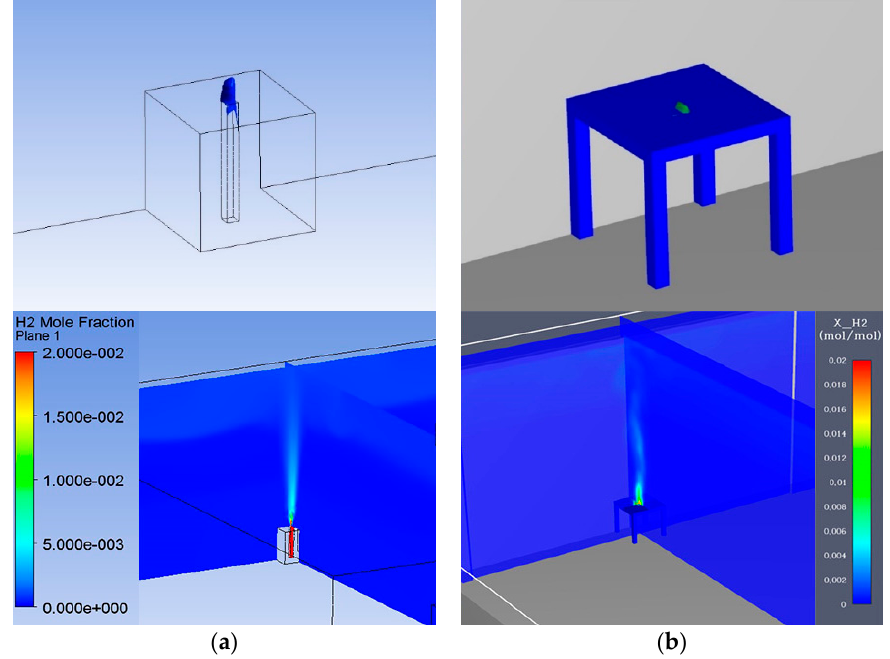
Figure 13. Iso-surface for hydrogen representing 50% concentration of LEL for ( a ) Ansys software and ( b ) FDS. and ( b )